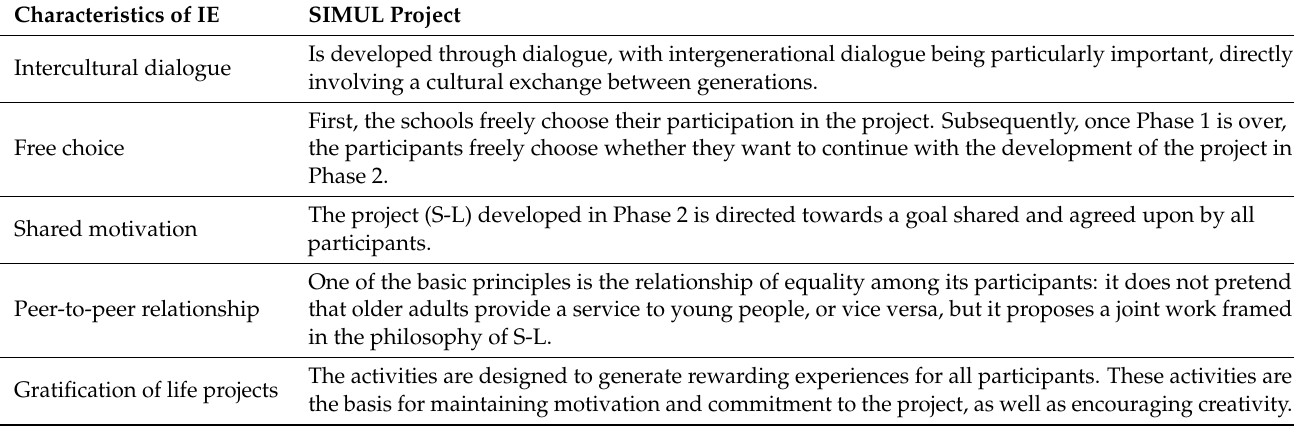
Table 3. Characteristics of Intergenerational Education (IE) in the project.